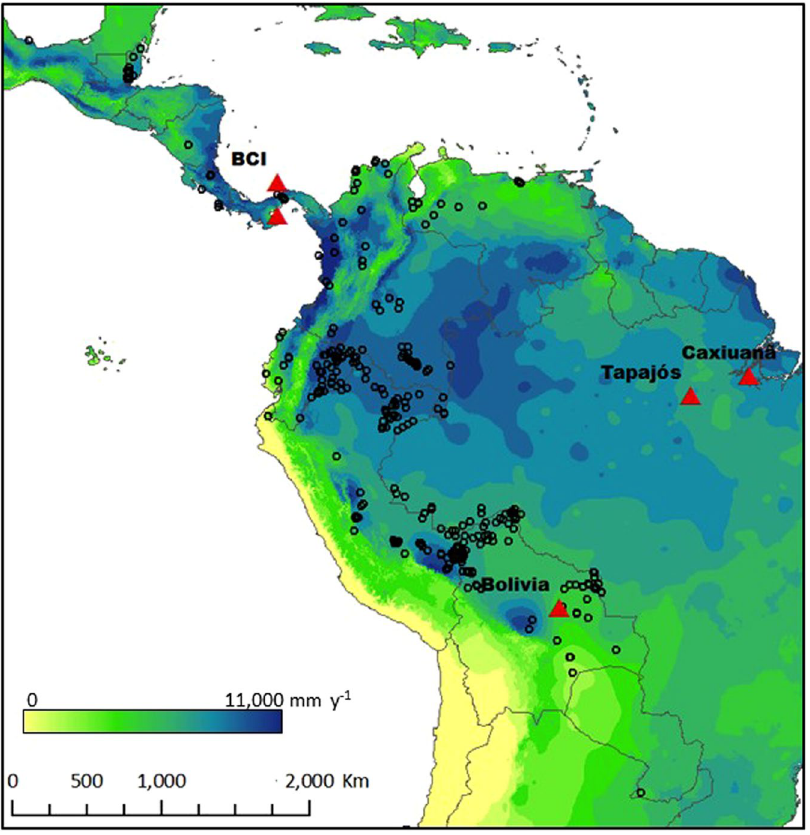
Figure 1. Location of experiments and observations analysed in this study. Triangles represent case studies investigated: two through-fall exclusion experiments in the Brazilian Amazon, Tapajós 40 and Caxiuanã 16 , field observations from the 1982–83 El Niño drought 17 , a seedling drought experiments in Panama (BCI) 4 and a seedling drought experiments in Bolivia 12 . Circles show ForestPlots.net 66, 78 and ATDN 1 inventory plots used to calculate water deficit affiliation (WDA) in ref. 39. Patterns within the map represent mean annual precipitation in mm y − 1 from WorldClim 79 generated in ref. 80. Note that case studies are located across a range of precipitation regimes and that Tapajós and Caxiuanã are ≈ 2000 km away from the area where WDA was calculated, allowing us to explore whether geographically distant populations will respond in the same way to droughts.